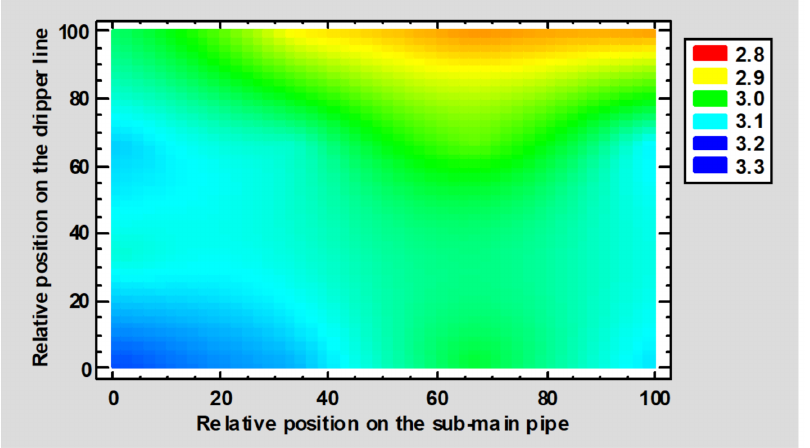
Figure 4. Kriging map for distribution of irrigation water (mm) in two dimensions in the greenhouses of Almer í a, where 0 corresponds to of the dripper line or sub-main pipe and 100 corresponds to the last emitter of the dripper line or sub-main pipe. Exponential adjustment with R 2 = 98.38%, root mean square error (RMSE) = 0.00107, and p ≤